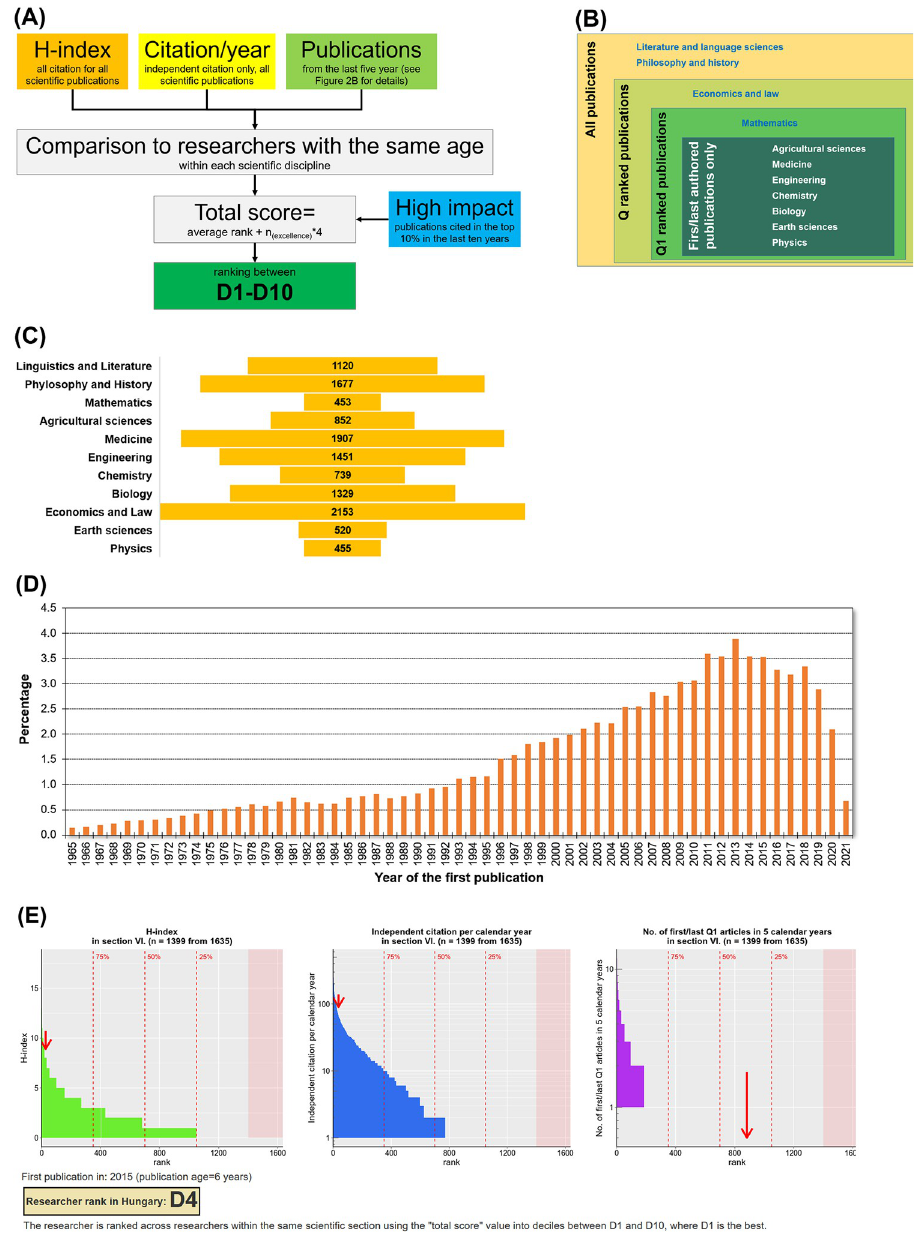
Fig 2. Setup of the scientometrics.org decision support tool. The included parameters (A), the scientific discipline- specific inclusion of publications (B), the distribution of researchers across the different scientific disciplines in the reference database (C), the distribution of age across the entire database (D), and representative example of the provided ranking for a randomly selected researcher